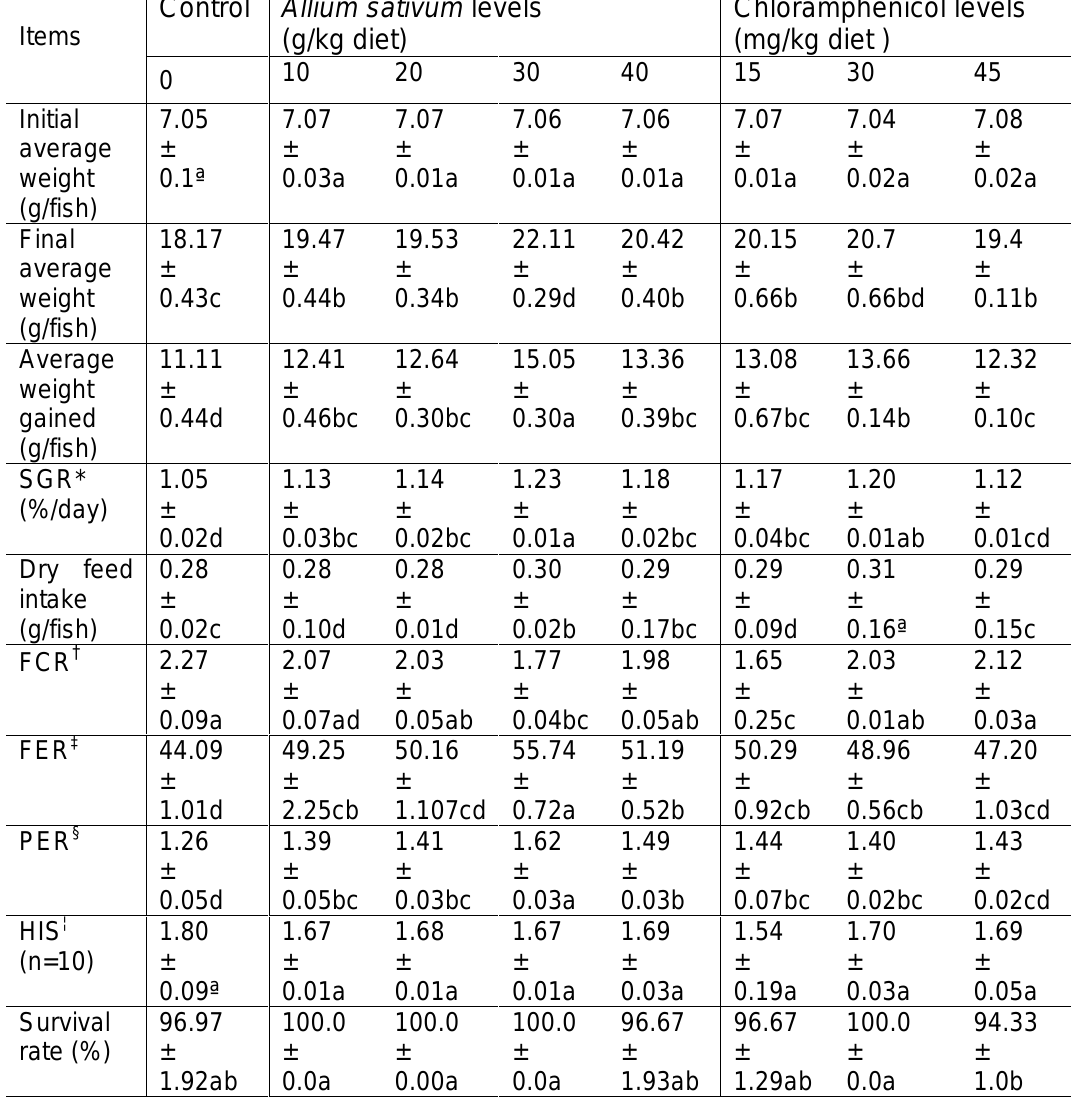
Table 2: Effects of garlic and antibiotic on growth parameters and survival rate of Nile tilapia ( O. niloticus ) fed on experimental diets during 90